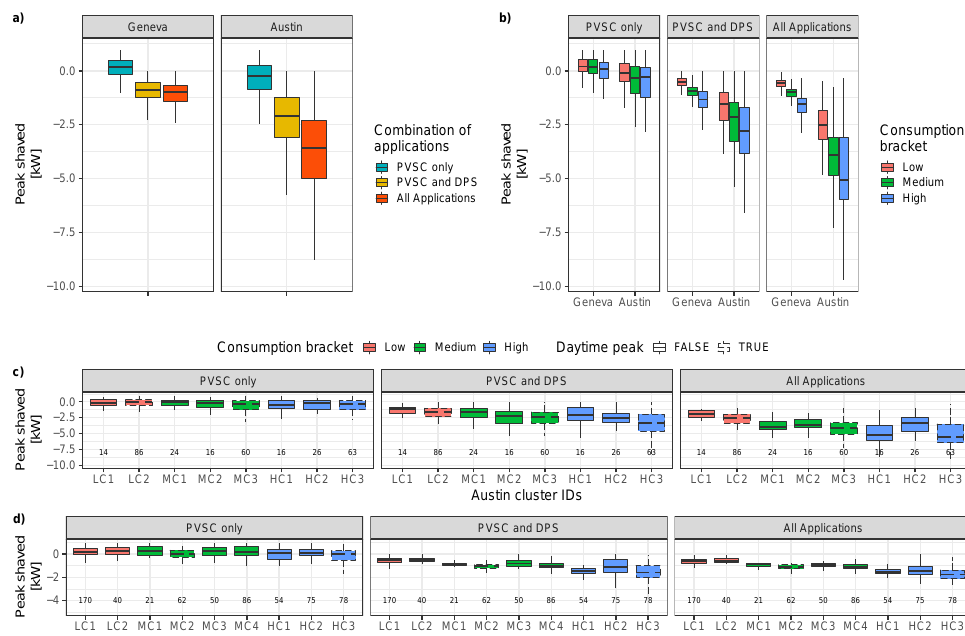
Figure 7. Peak flow shaved by PV-coupled batteries. ( a ) Comparing the impact of the combination of applications per country; ( b ) Comparing the consumption bracket impact per country and per combination of applications; ( c ) Comparing the impact of the load profile (cluster) per consumption bracket and per combination of applications for Austin and; ( d ) Comparing the impact of the load profile (cluster) per consumption bracket and per combination of applications for Geneva. Dashed boxplots represent households with peaks during daytime (i.e., from 10 am to 6 pm). The number of observation per cluster is indicated on top of the boxplots. PVSC stands for PV self-consumption and DPS for demand peak